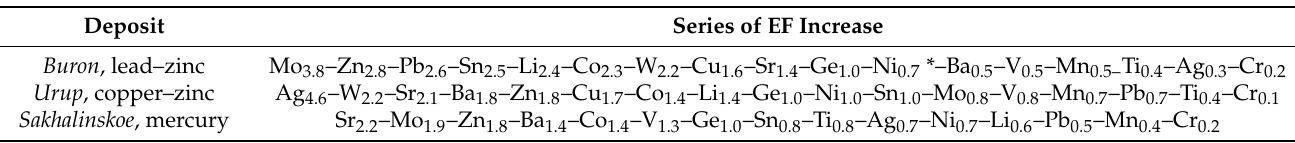
Table 1. Enrichment factors (EFs) of the chemical elements in the ash of woody plants from the ore fields of the North Caucasus geochemical province, calculated in relation to the regional abundances of the province. Deposit Series of EF Increase Buron ,